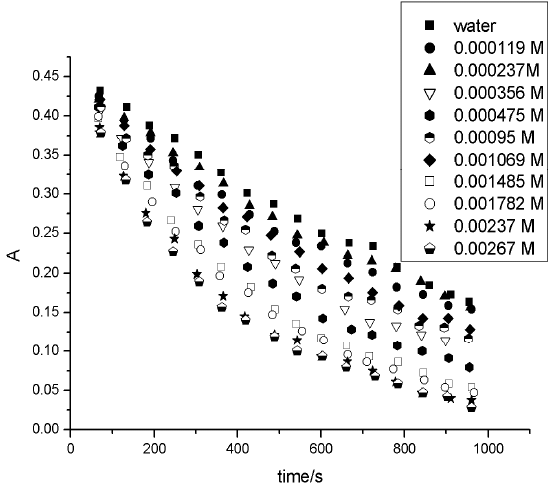
Figure 2. Integral kinetic curves of malachite green fading in the presence of HTAB.